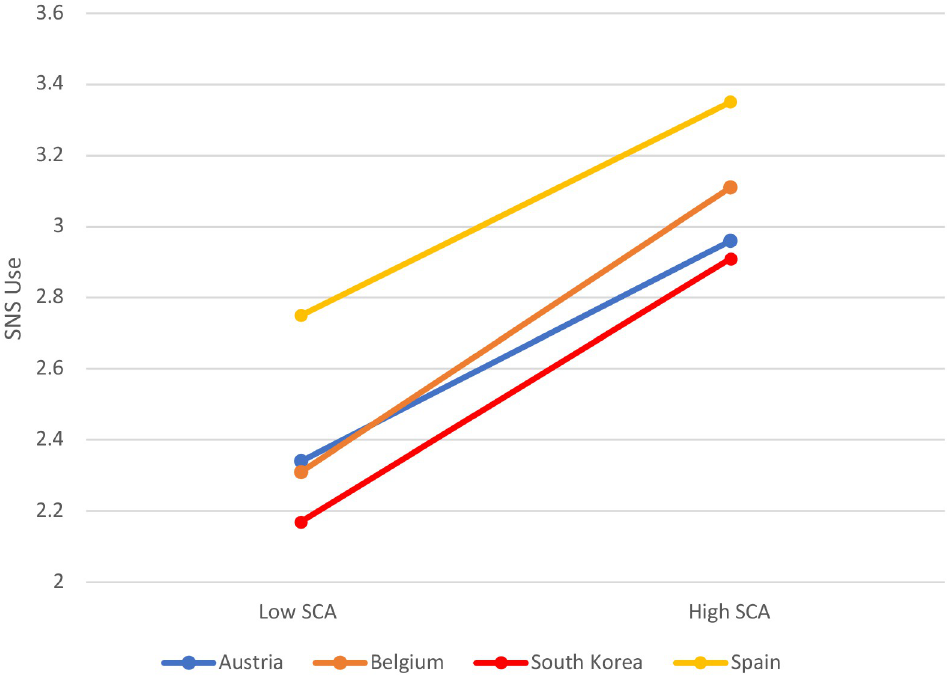
Fig 6. Social media use (SNS use) in low and high self-centered appearance focused use of social media (SCA).